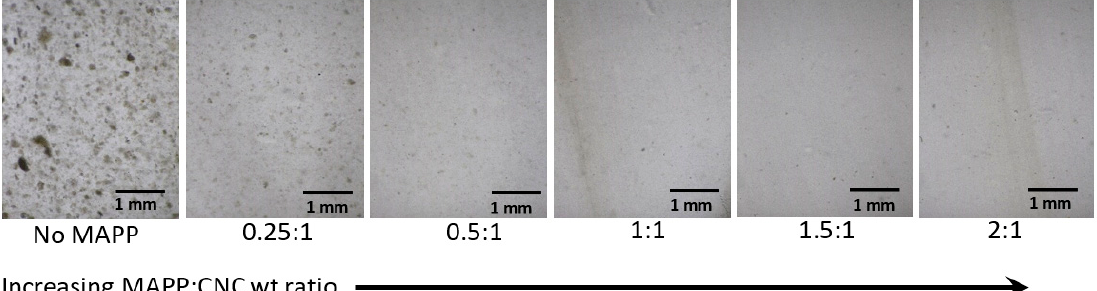
Figure 9. Thin films showing the effect of MAPP on the dispersion of CTAB-treated CNCs in PP. Materials were wet compounded in a thermokinetic mixer [68].